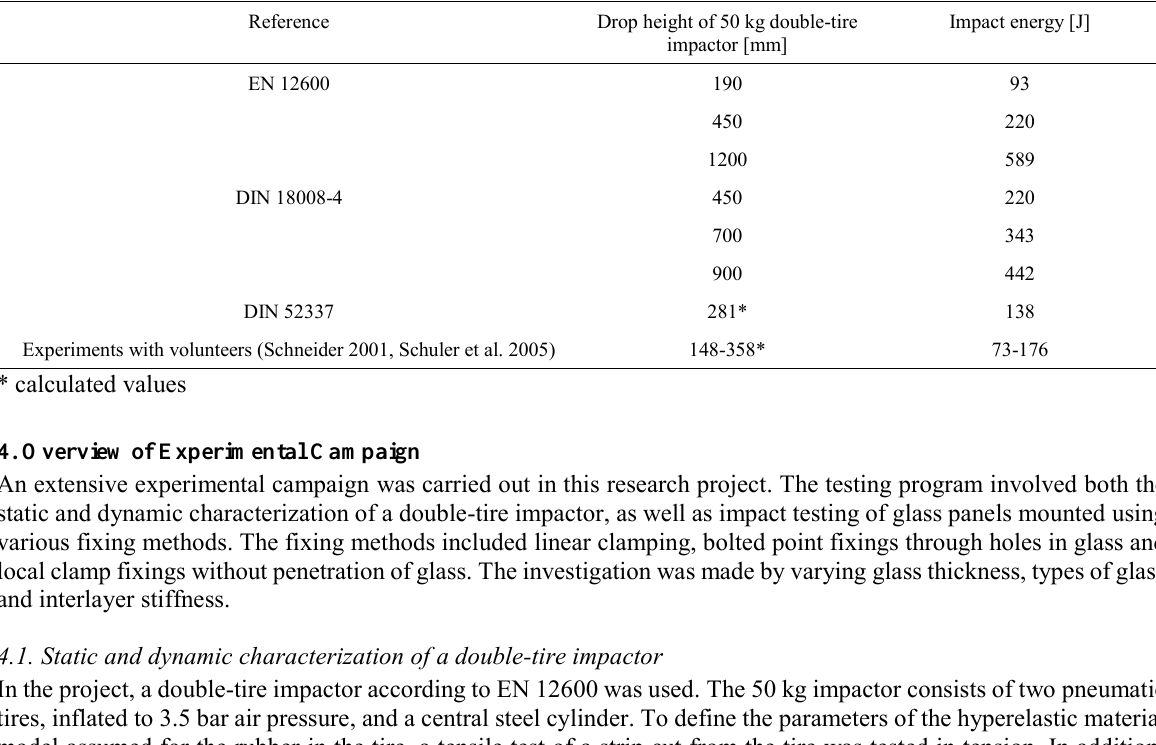
Table 1: Comparison of impact energies given by standards and produced by experiments with